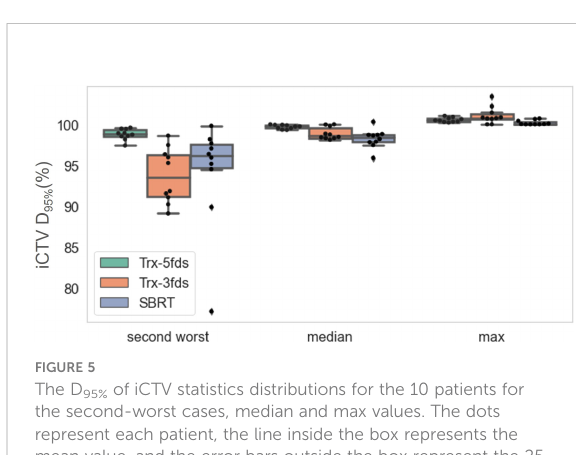
FIGURE 5 The D 95% of iCTV statistics distributions for the 10 patients for the second-worst cases, median and max values. The dots represent each patient, the line inside the box represents the mean value, and the error bars outside the box represent the 25- 75 th percentile of the scattered